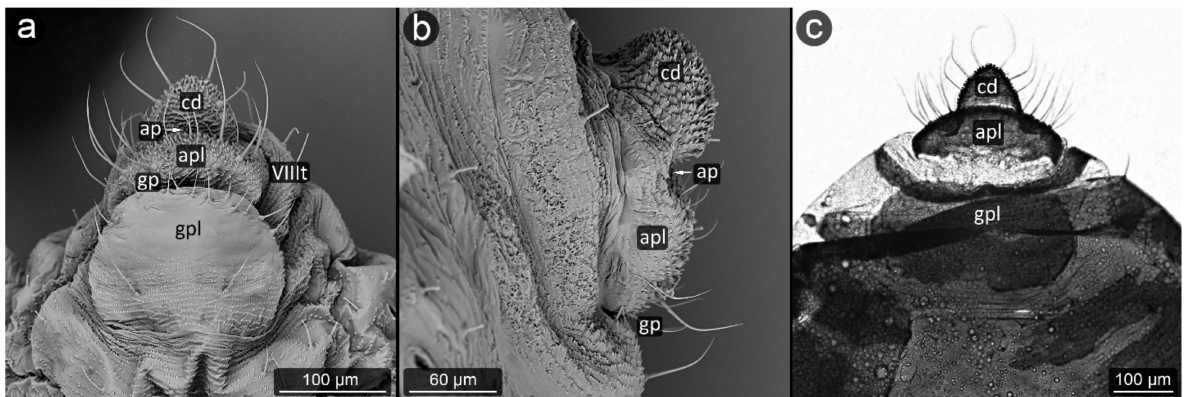
Figure 13. Perianal structure of Brachycaudus tragopogonis ; ( a )—abdominal view (SEM), ( b )—lateral view (SEM), ( c )—rear view in light microscopy. Abdominal tergite VIII: with a row of six short, blunt setae, slightly capitate at the apices.